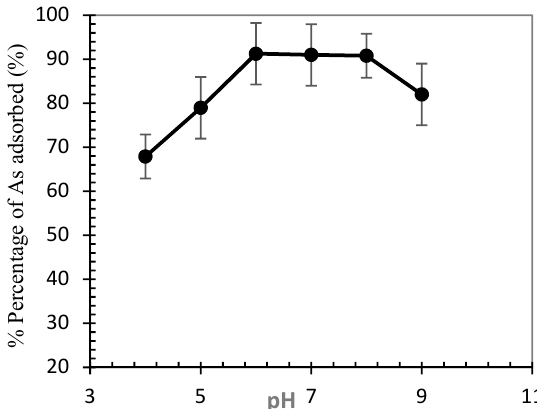
Figure 5. E ff ect of pH solution on the arsenic removal e ffi ciency (initial arsenic concentration: 0.075 g / L; Figure 5. Effect of pH solution on the arsenic removal efficiency (initial arsenic concentration: 0.075 sorbent dosage: 2 g / L; agitation rate: 150 rpm; time: 15 g/L; sorbent dosage: 2 g/L; agitation rate: 150 rpm; time: 15 min).